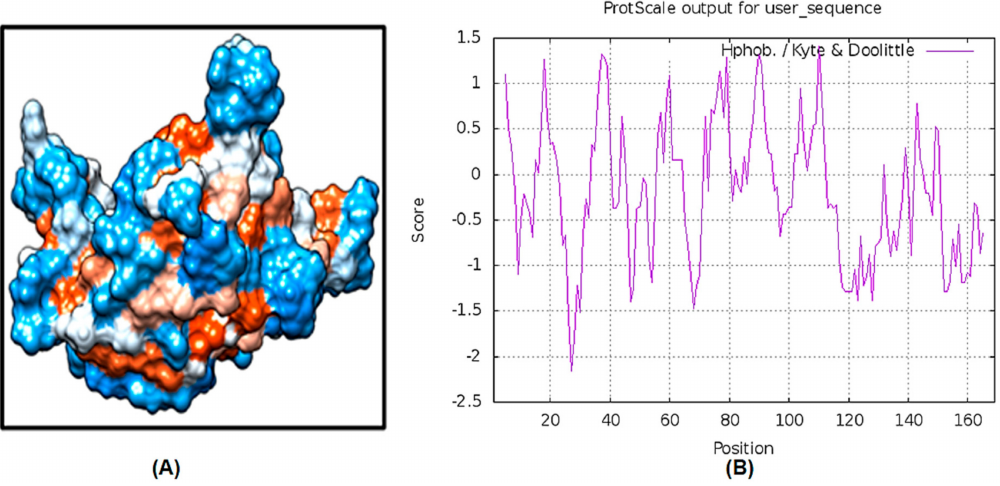
Figure 2. Analysis of LuxS protein hydrophobicity. ( A ) the hydrophilic areas of the LuxS protein are shown in blue, and hydrophobic regions are shown in red, while white represents areas with hydrophobicity values of 0.0. ( B ) Kyte and Doolittle hydropathy plot showing that the LuxS protein is moderately